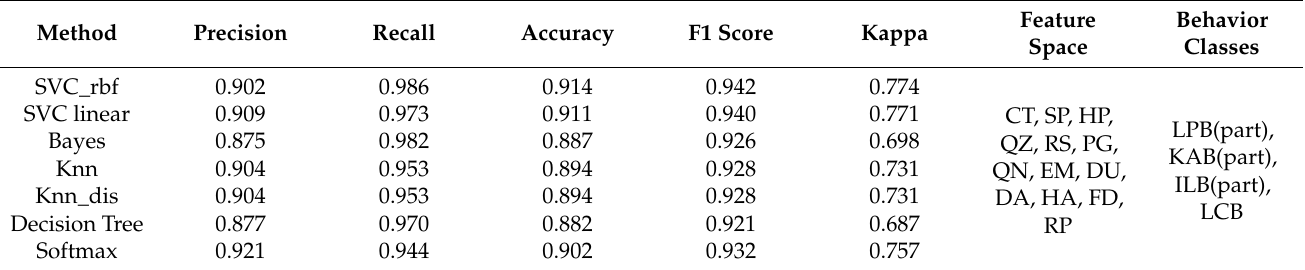
Table 4. FGDEM’s optimal solution and optimal feature space.